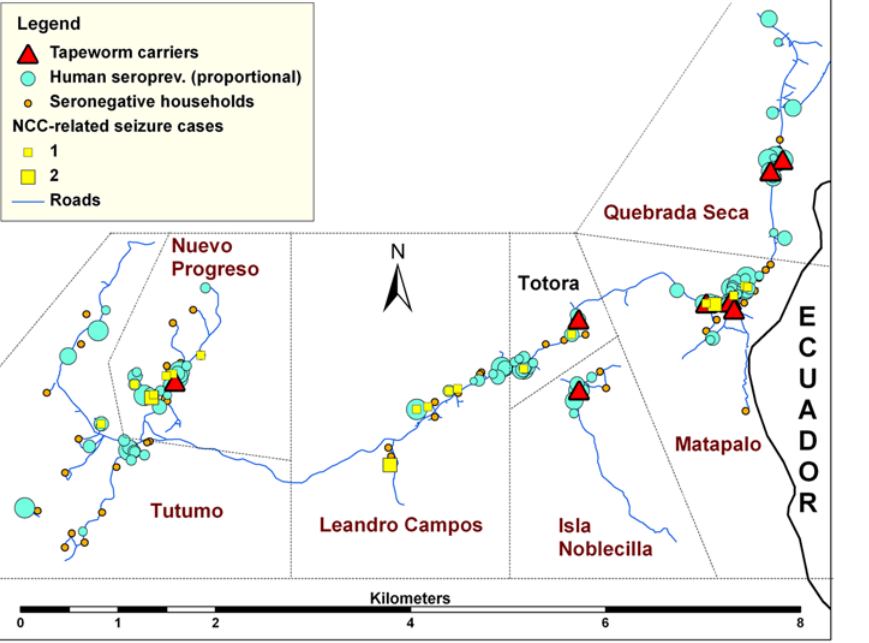
Figure 1. Proportion seroprevalence of human cysticercosis and location of T.solium tapeworm carriers and NCC-related cases, Tumbes, Peru, 1999. Two households with tapeworm carriers in Matapalo are virtually superimposed and cannot be differentiated visually. In the absence of defined community boundaries, straight lines were drawn to delimit villages respecting the self-reported area of residence data provided by each